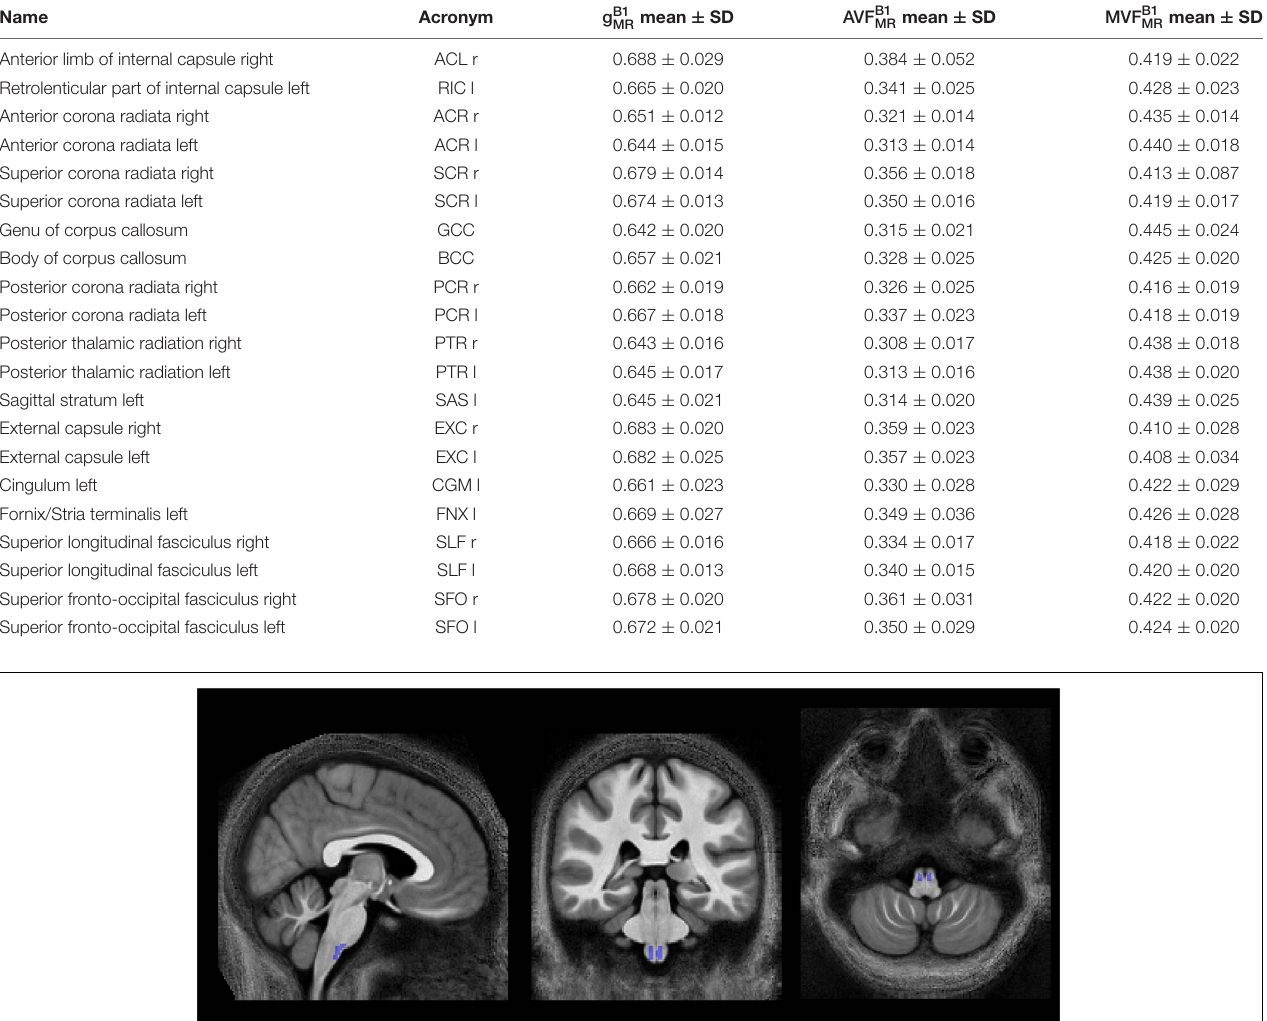
TABLE 1 | Group-averaged mean and standard deviation (SD) of g B1 MR , MVF B1 MR , and AVF B1 MR in 21 high-SNR ROIs.